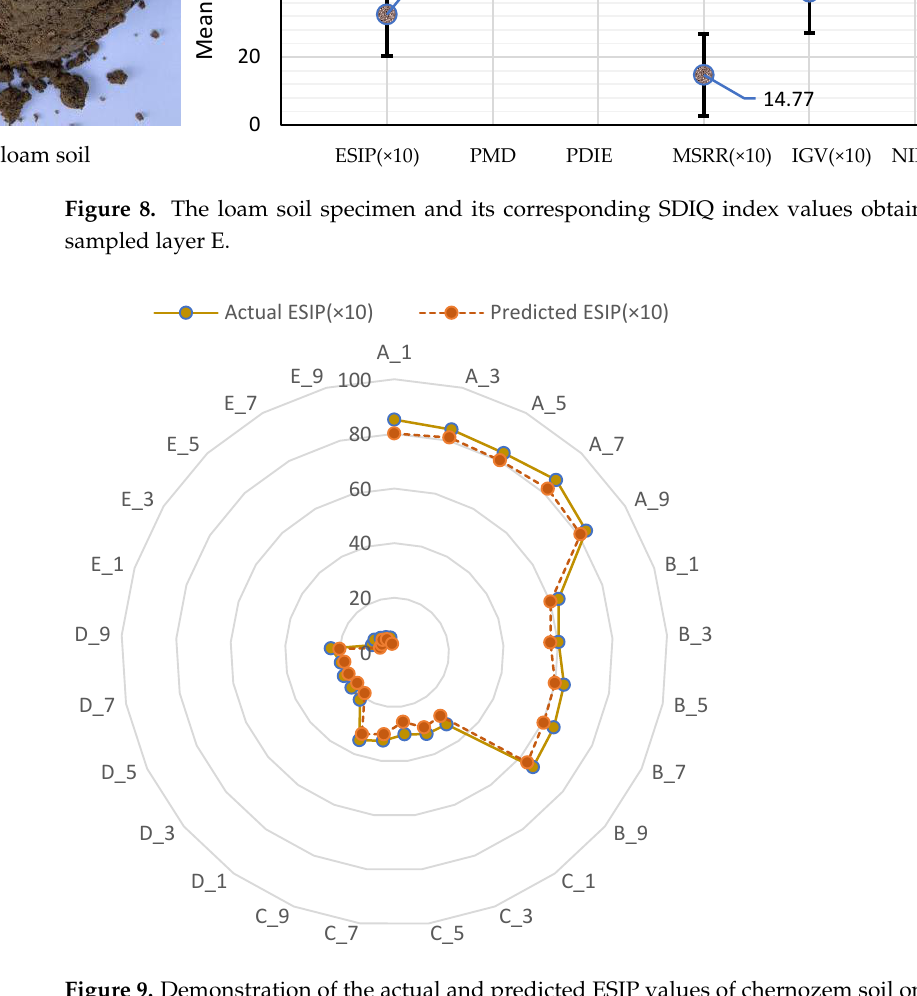
Figure 9. Demonstration of the actual and predicted ESIP values of chernozem soil on tests A_1 to E_10, implemented on layers A – E, respectively.